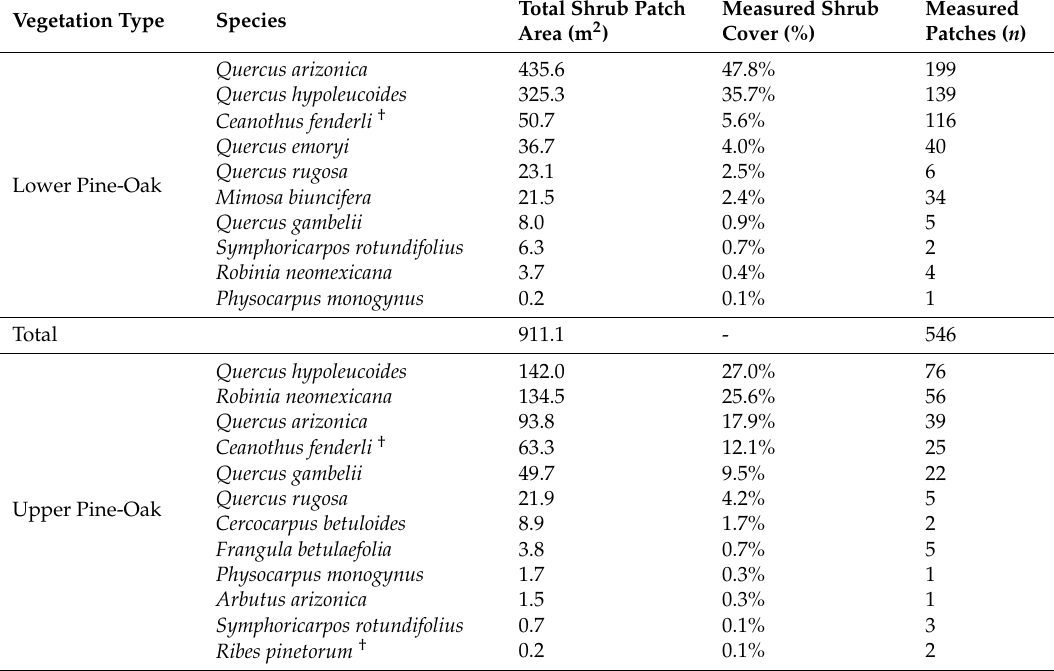
Table 3. Relative dominance of shrub species by vegetation type within the study area located in the Chiricahua Mountains, Arizona,